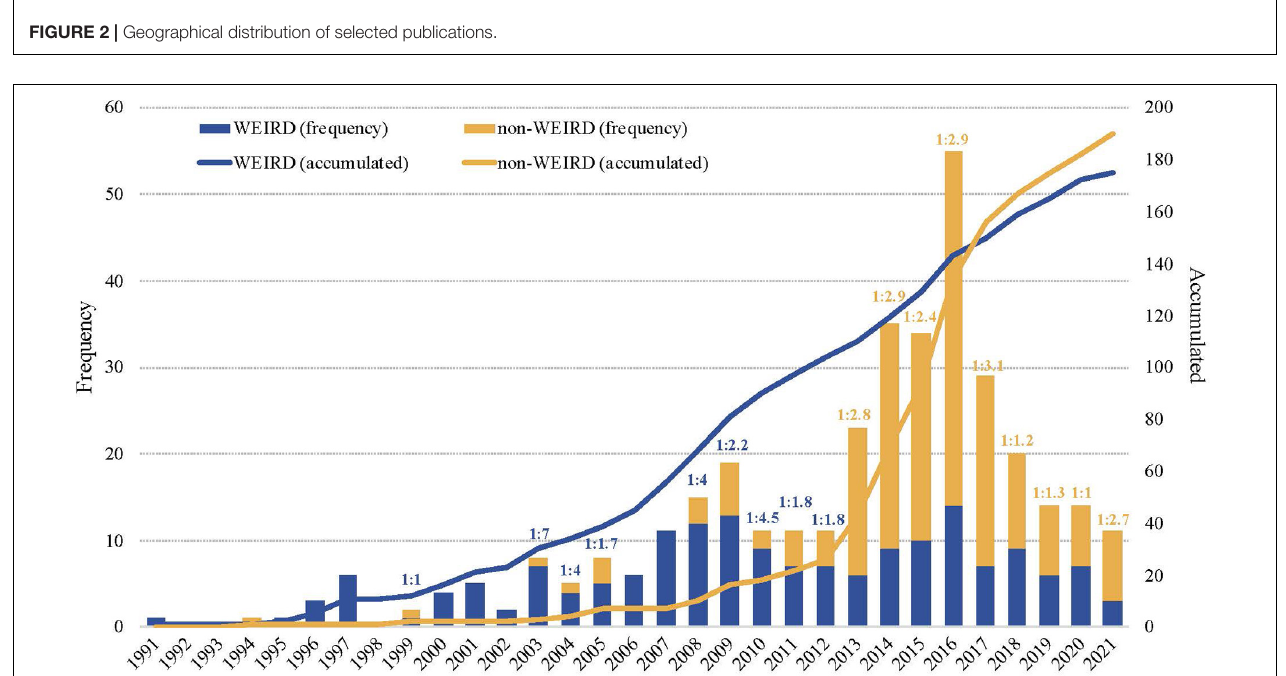
FIGURE 3 | Temporal distribution of publications, accumulated frequency and WEIRD/non-WEIRD publication ratio.